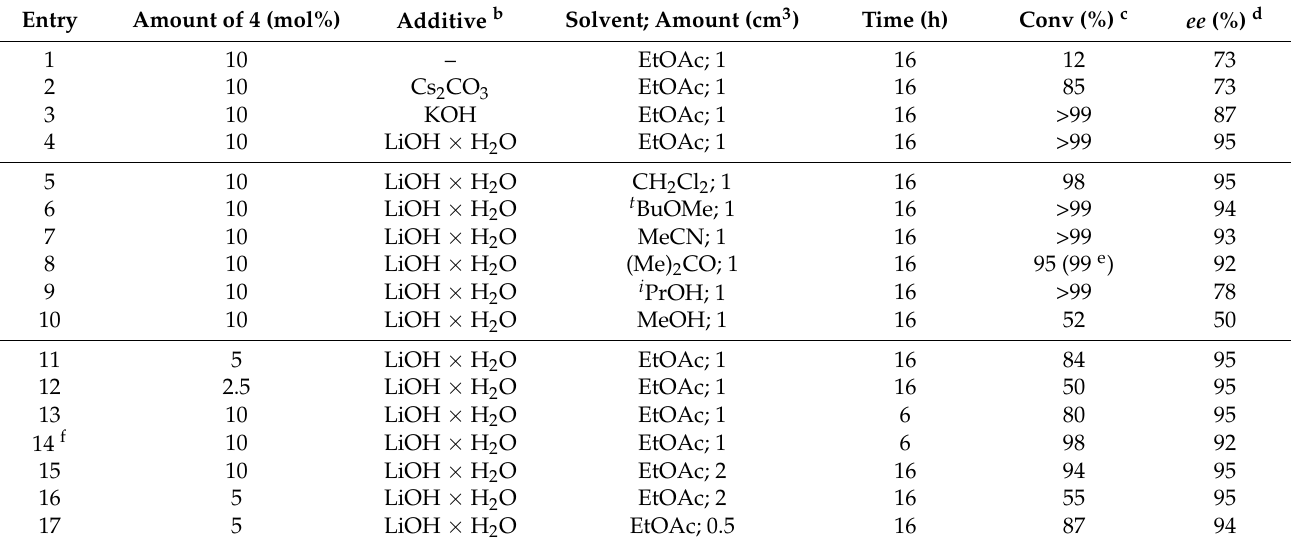
Table 1. Michael addition of 2 to 1a catalysed by L -Asp-OEt ( 4 ): effect of reaction conditions a